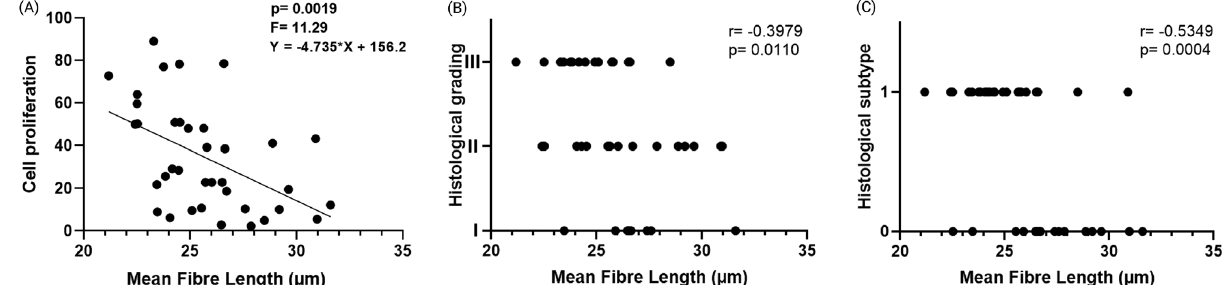
Figure 4. ( A ) Linear regression for the fibre length and the cell proliferation; ( B ) Spearman’s correlation for the fibre length and the histological grades I, II and III; ( C ) Spearman’s correlation for the fibre length and